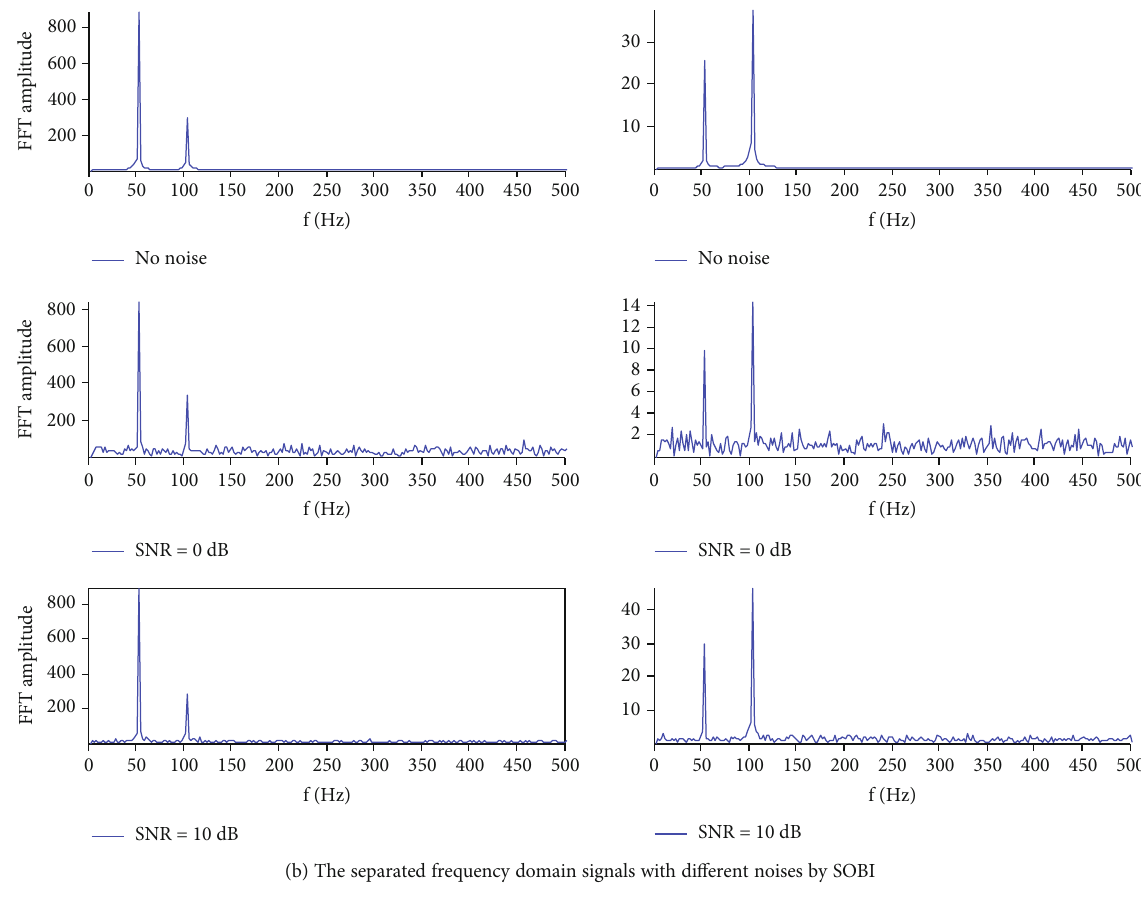
(b) The separated frequency domain signals with di ff erent noises by SOBI Figure 5: Time-frequency waveform of the SOBI